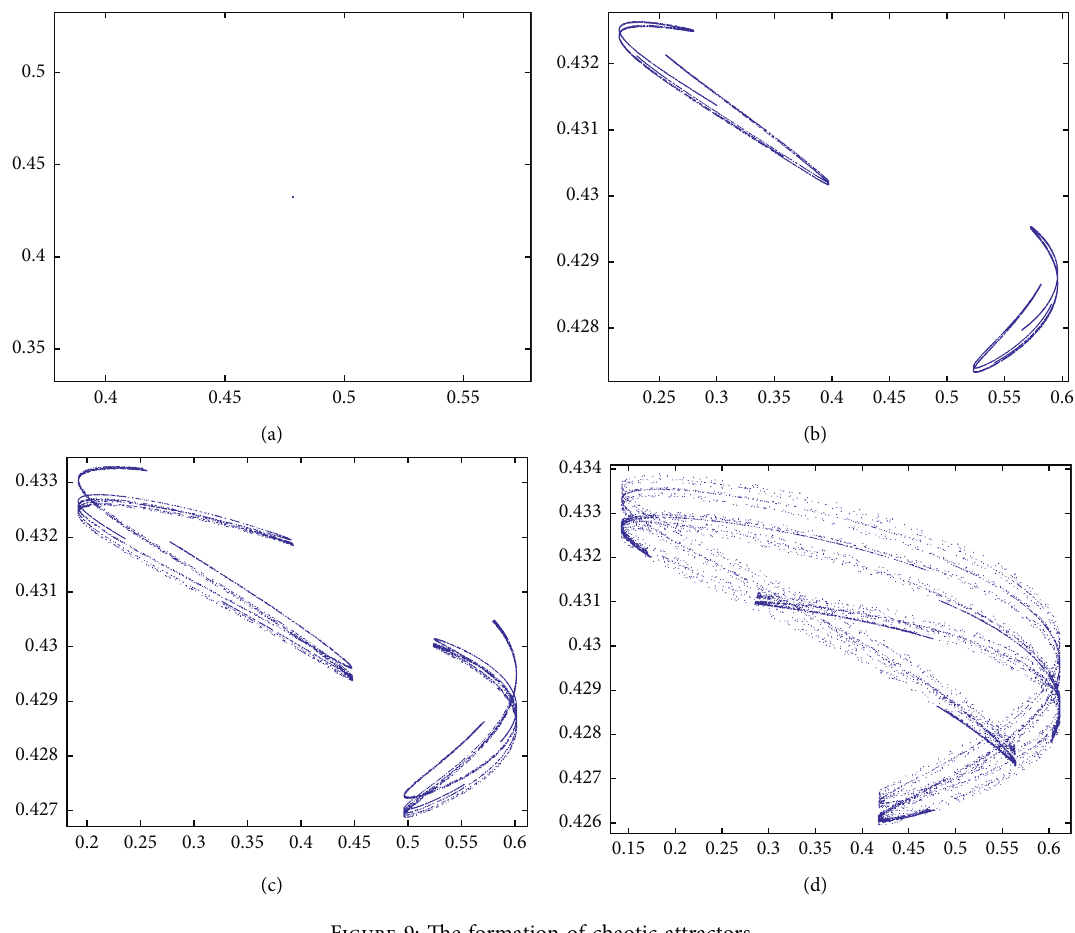
Figure 9: The formation of chaotic attractors.